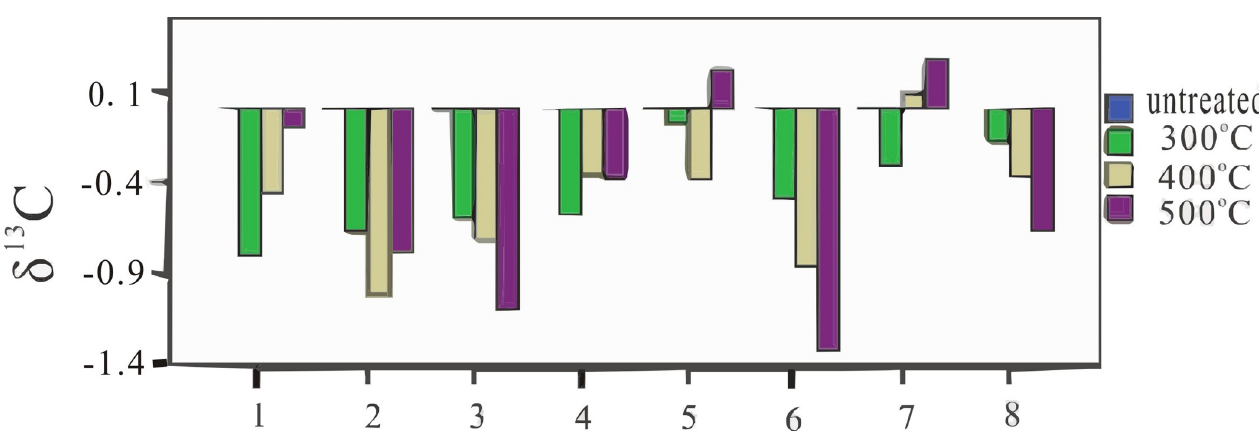
Fig 2. δ 13 C (‰ VPDB) mean fractionation values of wood samples of Pinus sp. and Quercus sp. at different temperatures. ( δ 13 C mean fractionation values of untreated wood is zero. 1- Pinus armandii ; 2- Pinus massoniana ; 3- Pinus tabulaeformis ; 4- Quercus acutissima Carr ; 5- Quercus aliena Blume ; 6- Quercus aliena Blume var.; 7- Quercus dentata Thunb ; 8- Quercus mongolica Fischer ).